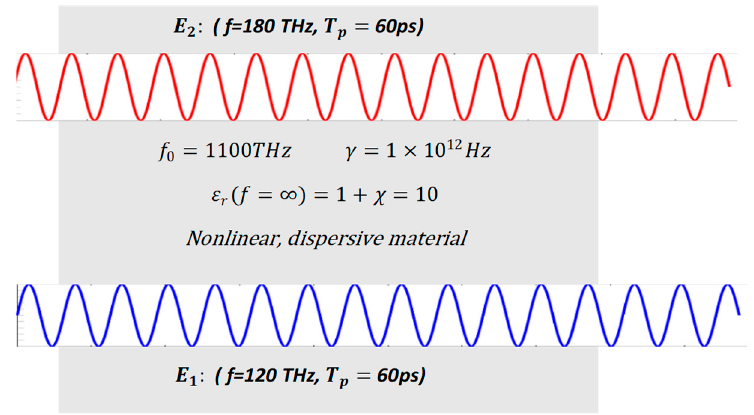
Figure A1. Configuration for frequency up-conversion.